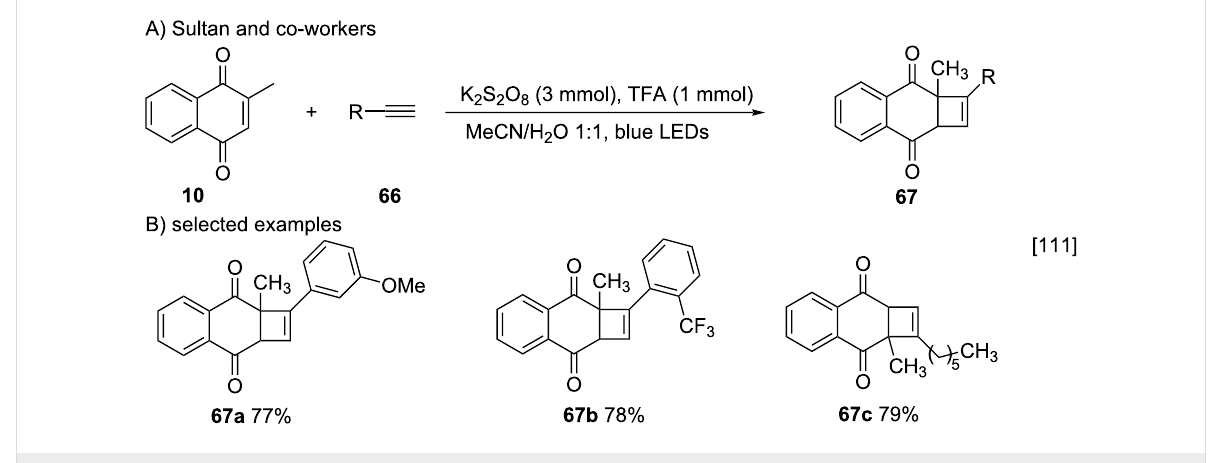
Scheme 18: Synthesis of cyclobutene derivatives of menadione.